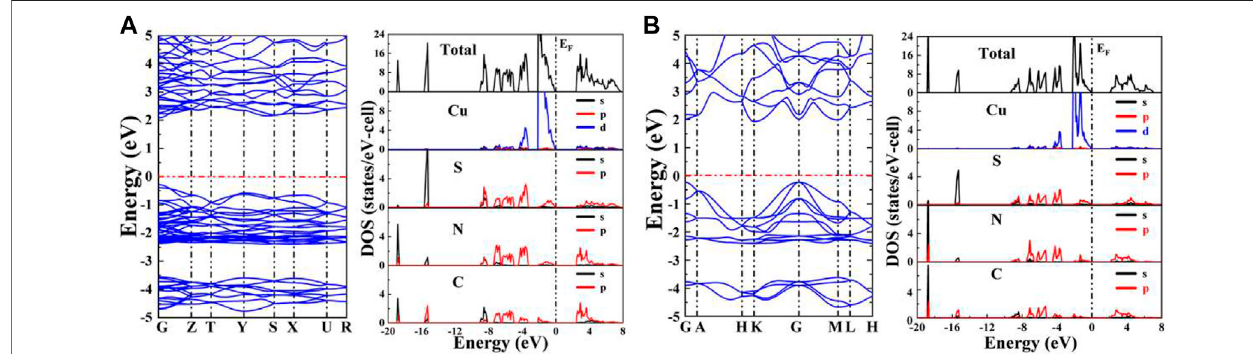
FIGURE 5 | Band structures and EPDOS of (A) α -CuSCN and (B) β -CuSCN.